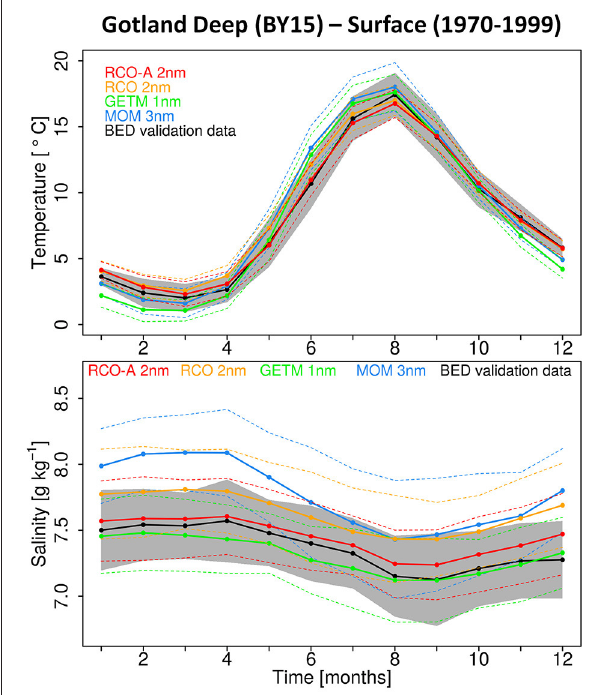
FIGURE 4 | Monthly mean temperature ( top ) and salinity ( bottom ) from BED observation data (black) and the ocean models RCO-A (red), RCO (orange), GETM (green), and MOM (blue) at 225m depth at Gotland Deep (BY15) for the years from 1970 to 1999. 1993 with 10.9 g kg − 1 and highest in 1977 with 13.6 g kg − 1 .